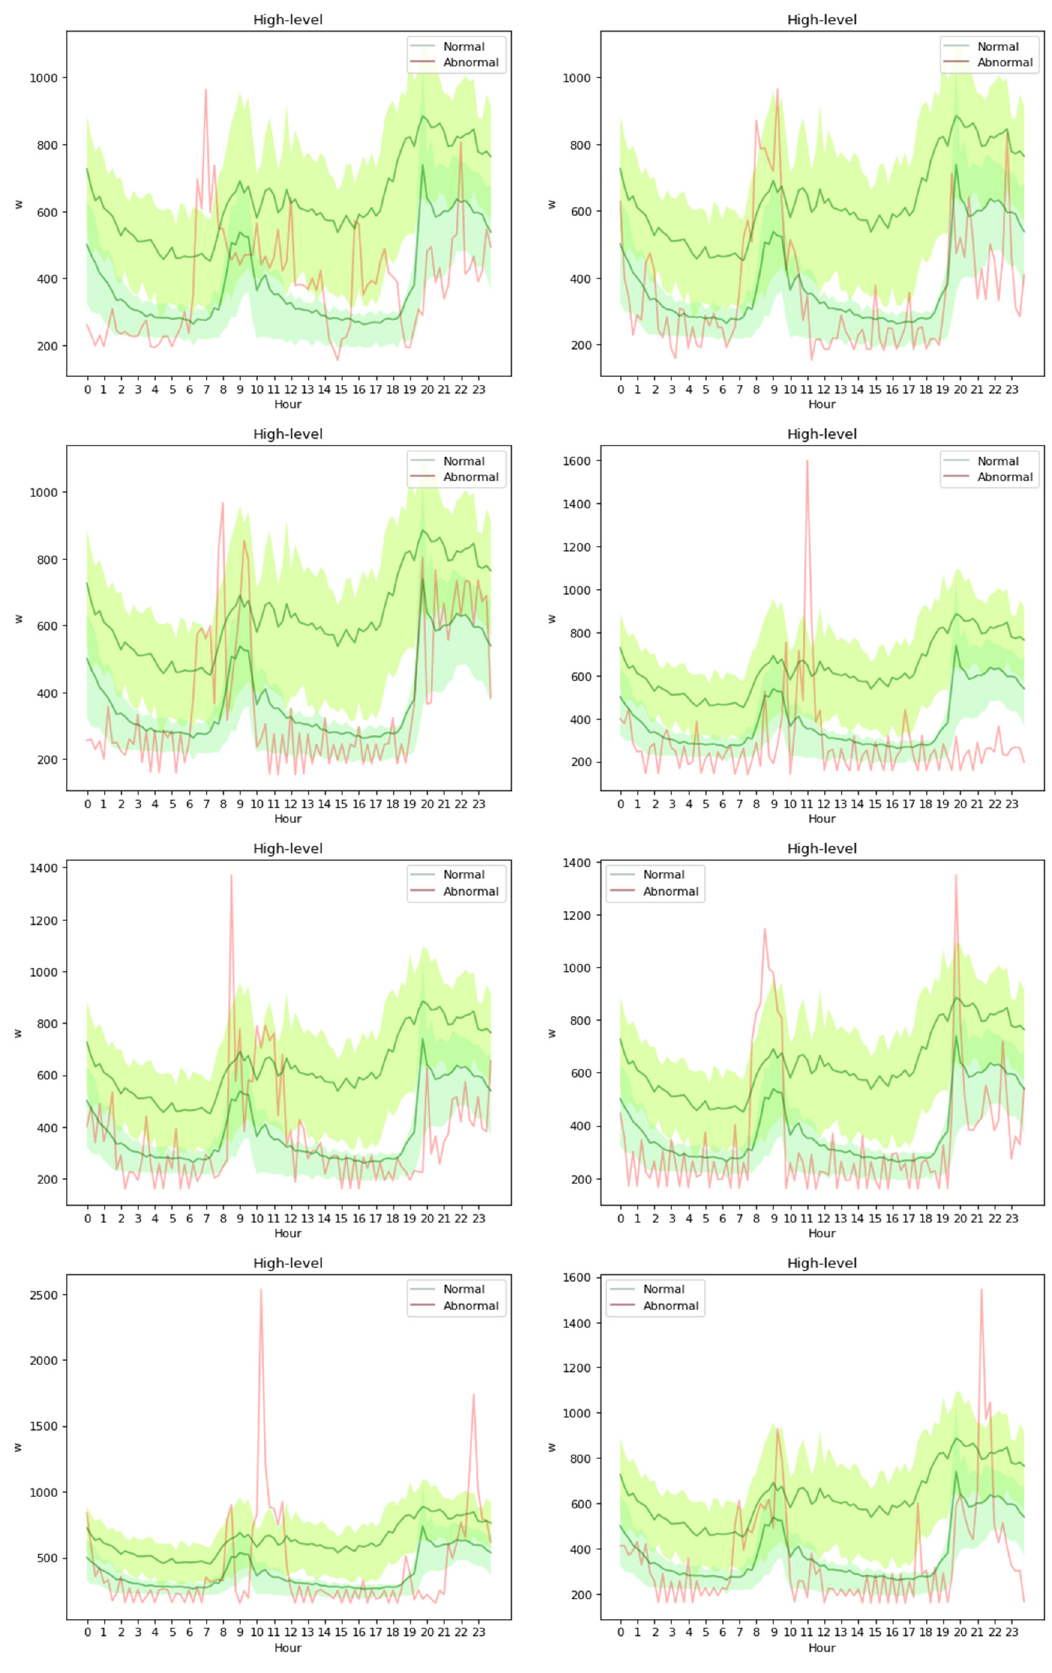
Figure A6. Load profiles of each abnormal electricity consumption events of User 03 using the high-level features.